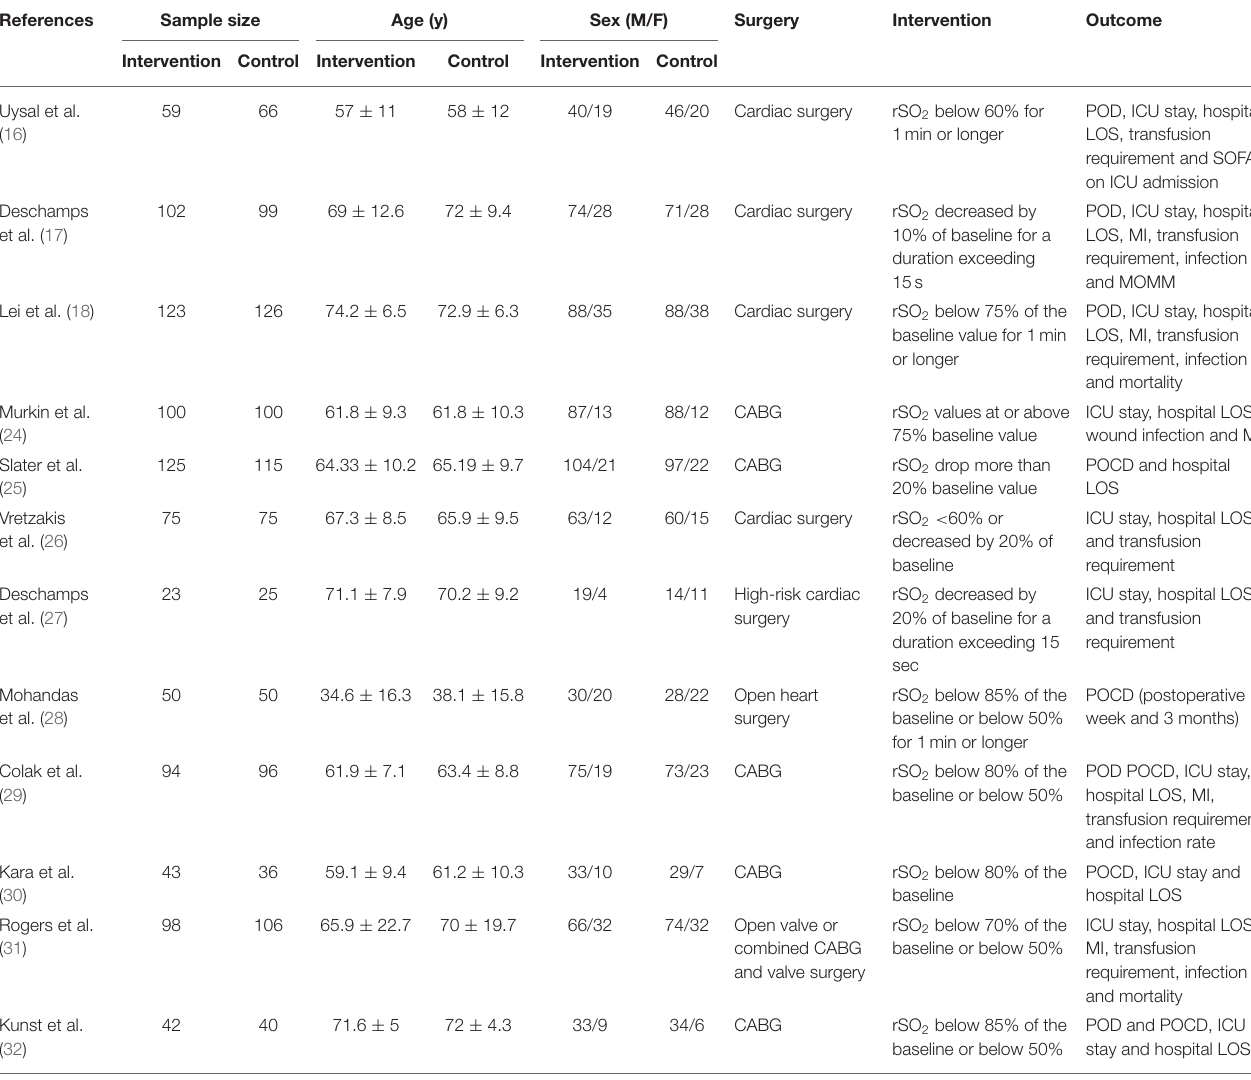
TABLE 1 | Baseline characteristics of included studies for